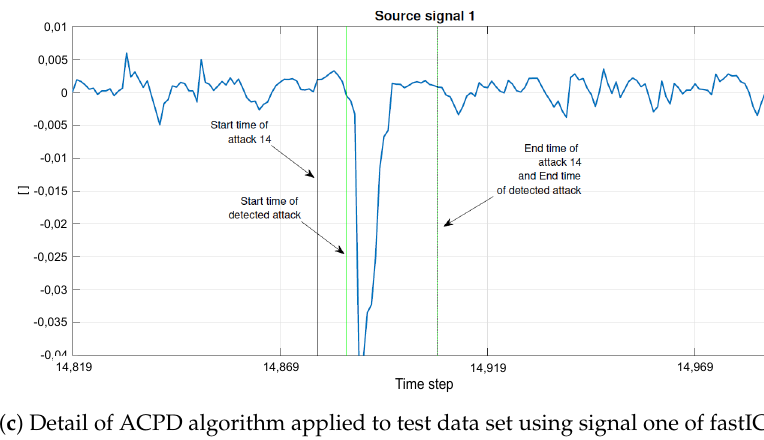
( c ) Detail of ACPD algorithm applied to test data set using signal one of fastICA applied to node J415, tank level at Tank T4 and flow at pumps PU6 and PU7 Figure 4. Complete data processing, illustrating fastICA and ACPD applied to Combination